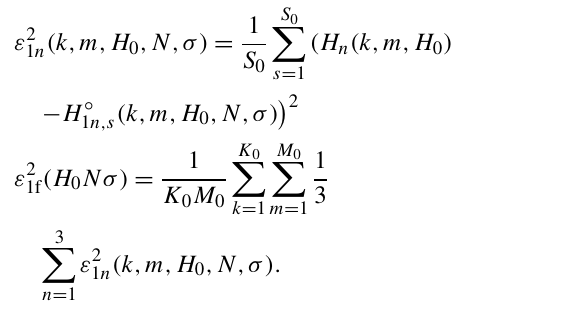
Figure 3. Results of calculation of the relative decrease factors for the errors: 1 – σ 0 = 0 . 5; 2 – σ 0 = 0 . 3; 3 – σ 0 = 0 . 1; 4 – σ 0 = 0 .